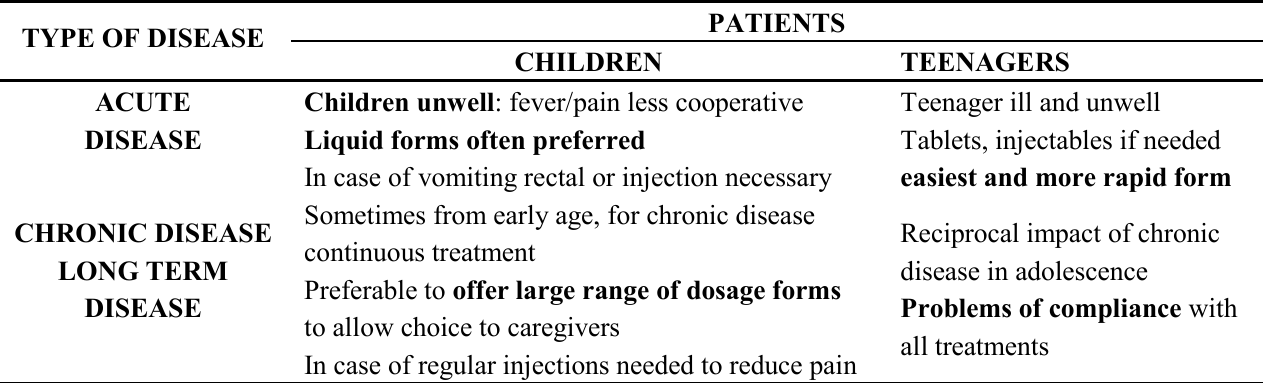
Table 1. Behavior of patient as a function of the type of disease